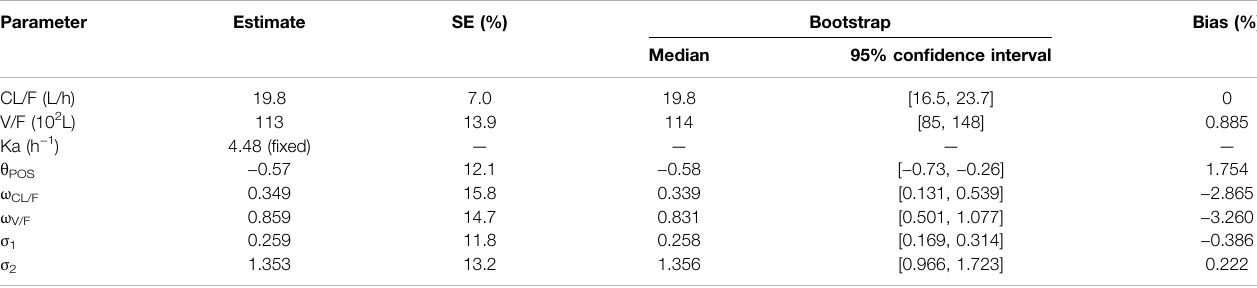
TABLE 2 | Parameter estimates of the fi nal model and bootstrap validation.